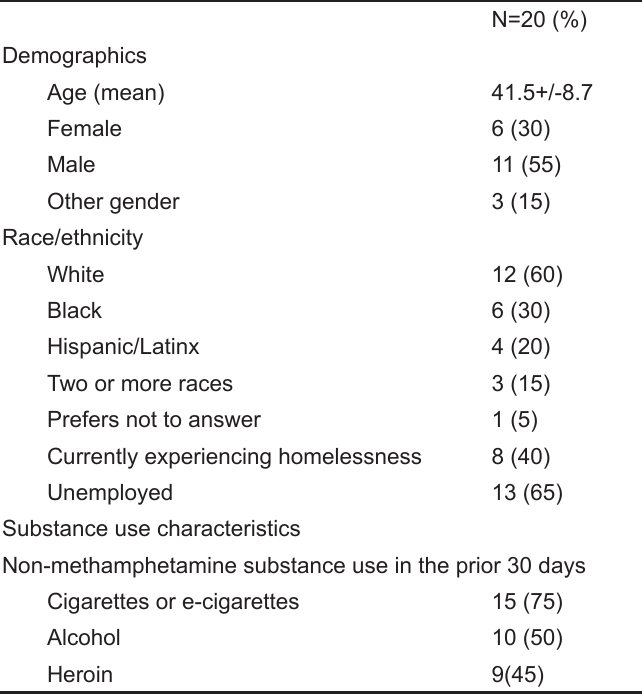
Table 1. Demographics, substance use characteristics, and medical characteristics of